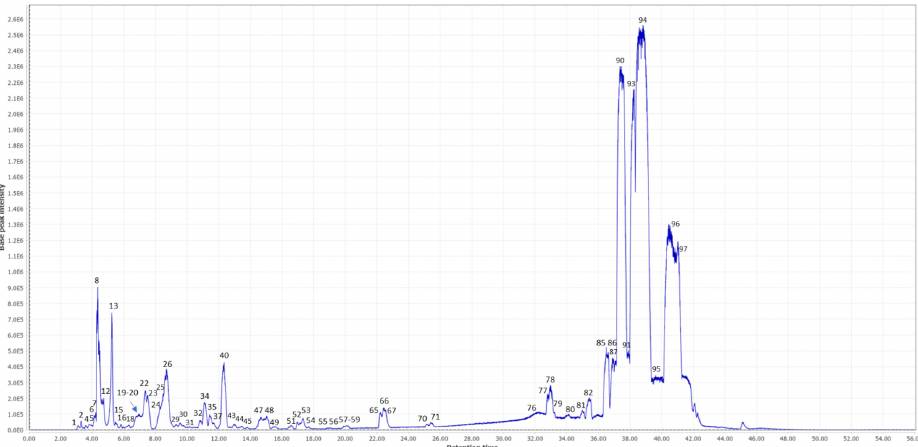
Figure 1. Base peak chromatogram (BPC) of the ethanolic extract of TN analyzed by UHPLC-ESI- QTOF-MS. The numbers refer to the dominant compounds in the BPC (see Table 1 for the tentative identity of these compounds).